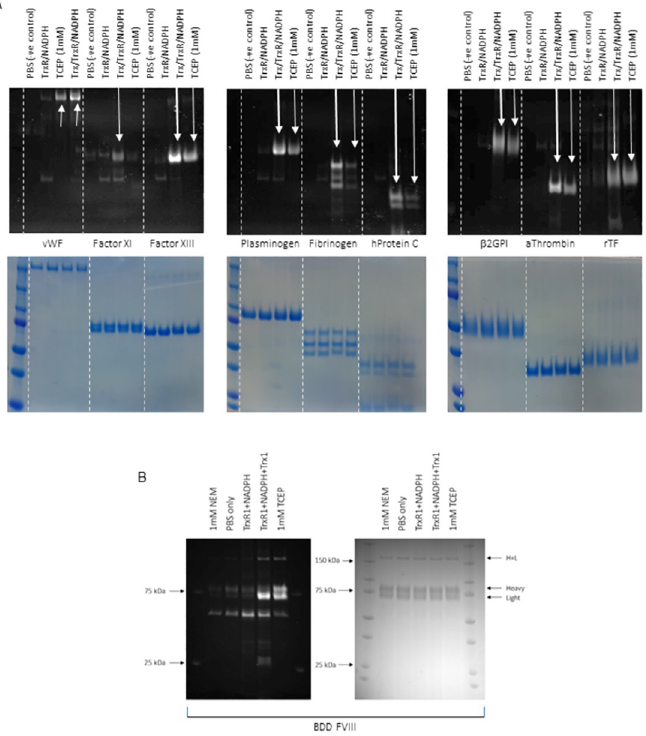
Fig 2. TCEP and Trx reduce plasma proteins important for coagulation and haemostasis. (A) Protein samples were reduced with thioredoxin or TCEP and free thiols labelled with Alexa 488-maleimide. Samples were separated on a 4–20% SDS-PAGE gel and visualised for the incorporation of the fluorescent label (top). Coomassie stains to show equal loading is also shown (bottom). (B) FVIII undergoes reduction by both thioredoxin and TCEP (Alexa 488-maleimide staining on the left, total protein [Coomassie staining] on the right).